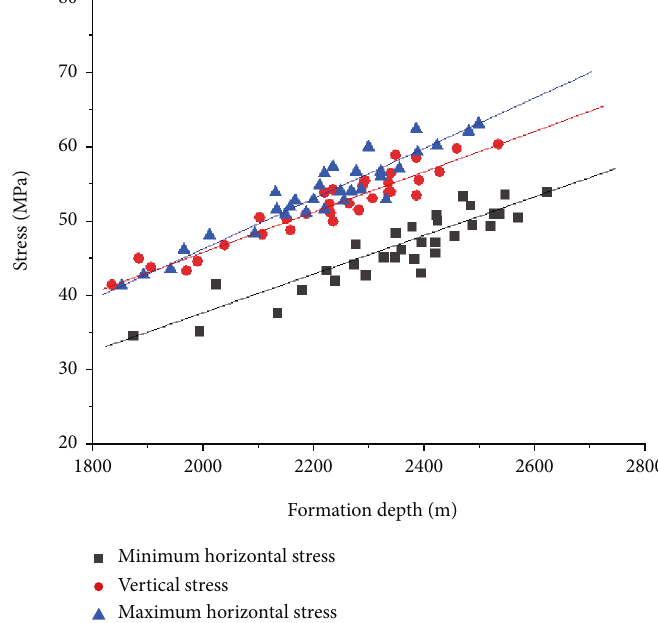
Figure 8: Relationship between the stress and the formation depth.